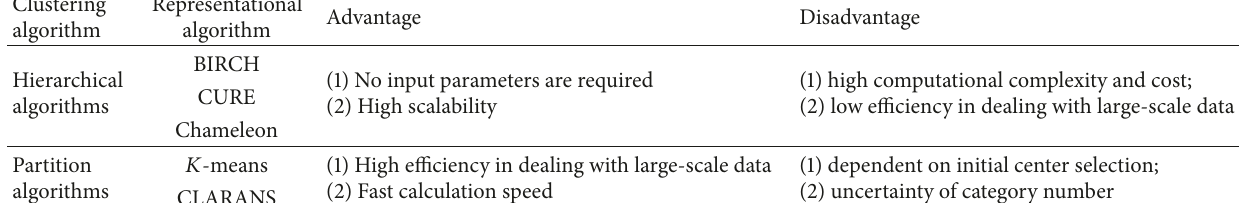
Table 3: Advantages and disadvantages of some unsupervised algorithms.